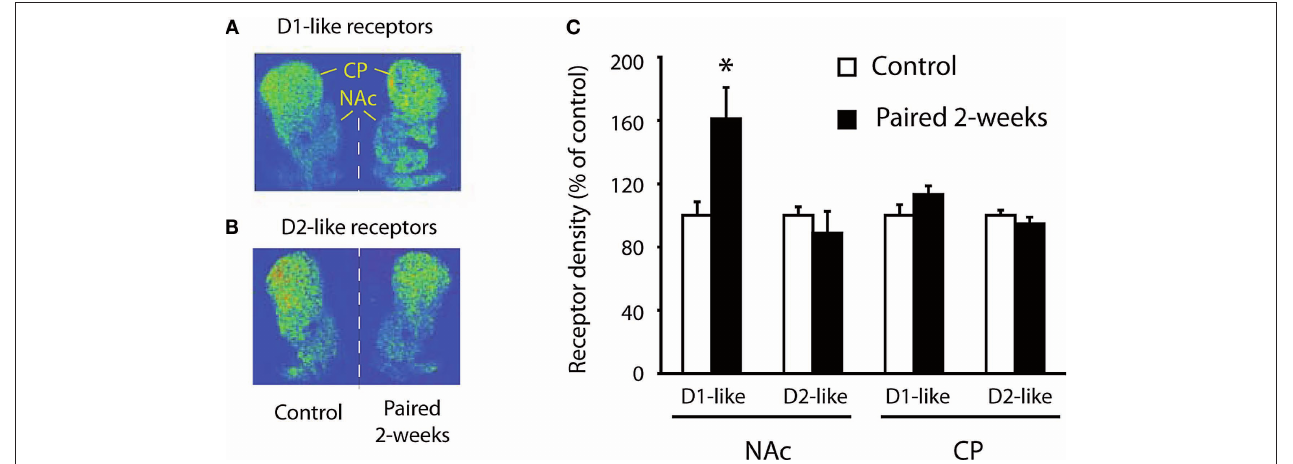
FIGURE 4 | Up-regulation of D1-like receptors within the NAc of pair bonded animals. (A) Representative examples of D1-like receptor binding within the dorsal and ventral striatum of sexually naive adult male prairie voles (left) and pair bonded males (paired with a female for 2 weeks; right). (B) Representative examples for